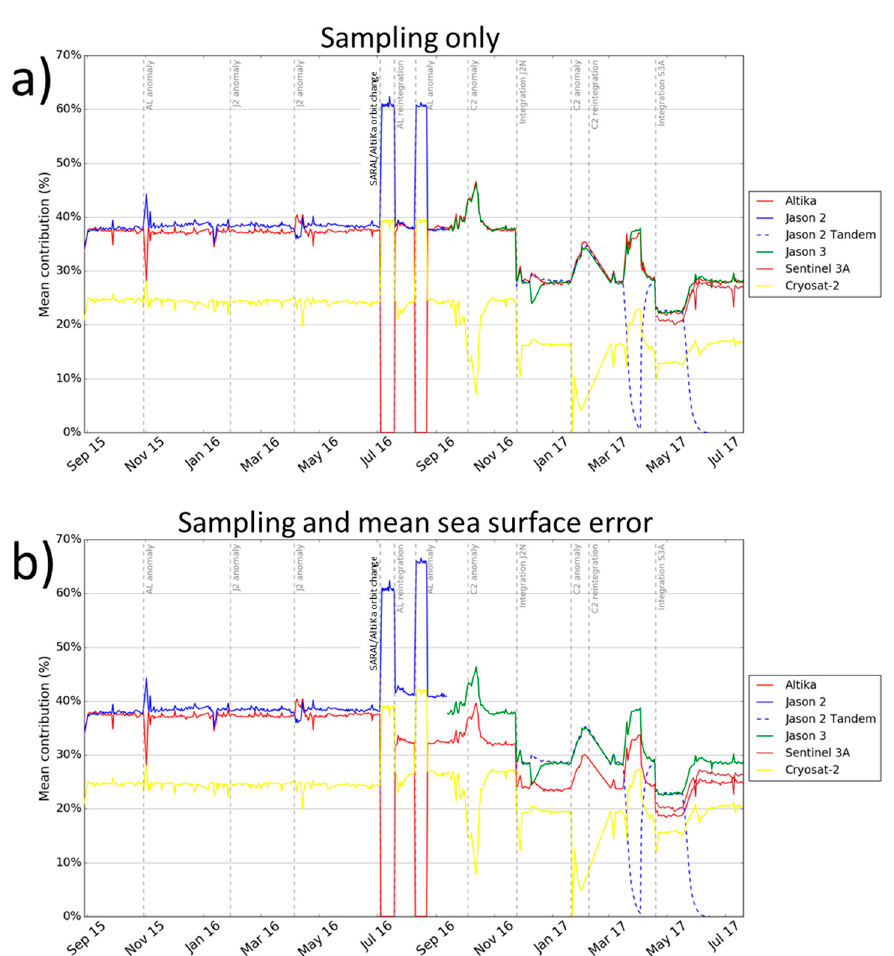
Figure 9. Relative contribution (%) of each altimeter to the multi-altimeter maps of the sea-level thematic assembly center of Copernicus Marine Environment Monitoring Service (CMEMS) from September 2015 to July 2017. Panel ( a ) measures the impact of SARAL DP sampling change only (the measurement error is assumed to be constant between the 35-day and the drifting phase). Panel ( b ) accounts for both the sampling change the increased error (sub-optimal mean sea surface model along the new uncharted orbit).